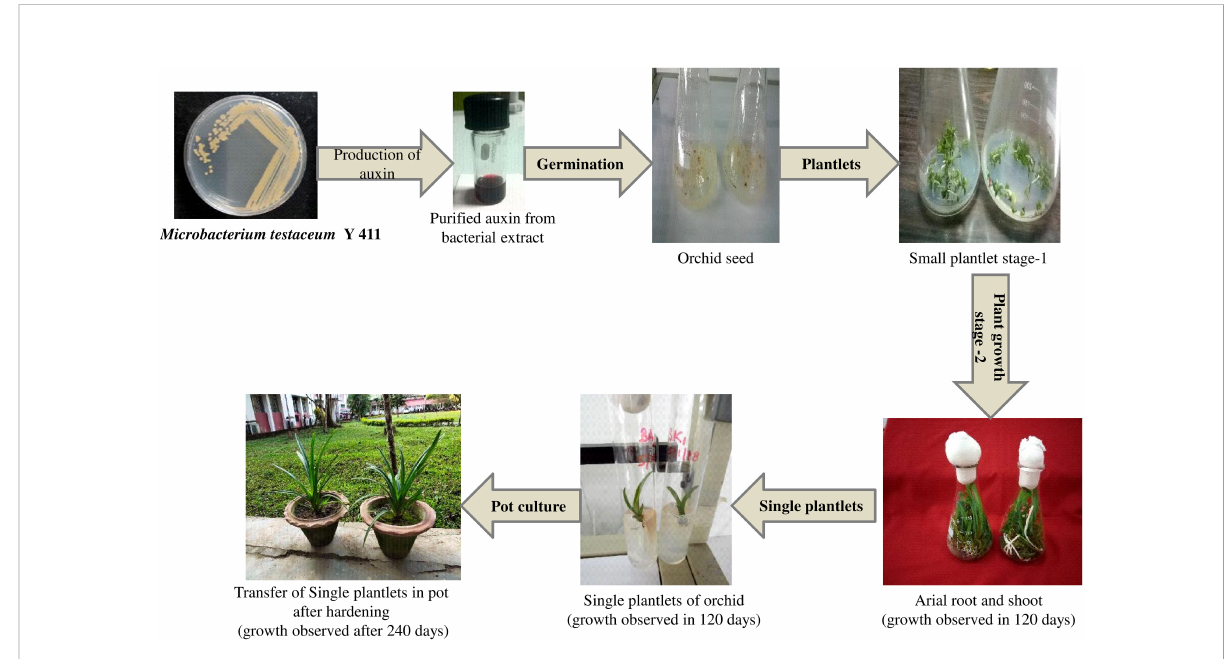
FIGURE 8 In-vitro propagation of the orchid ( Cymbidium aloifolium ) using puri fi ed extracted auxin from Microbacterium testaceum